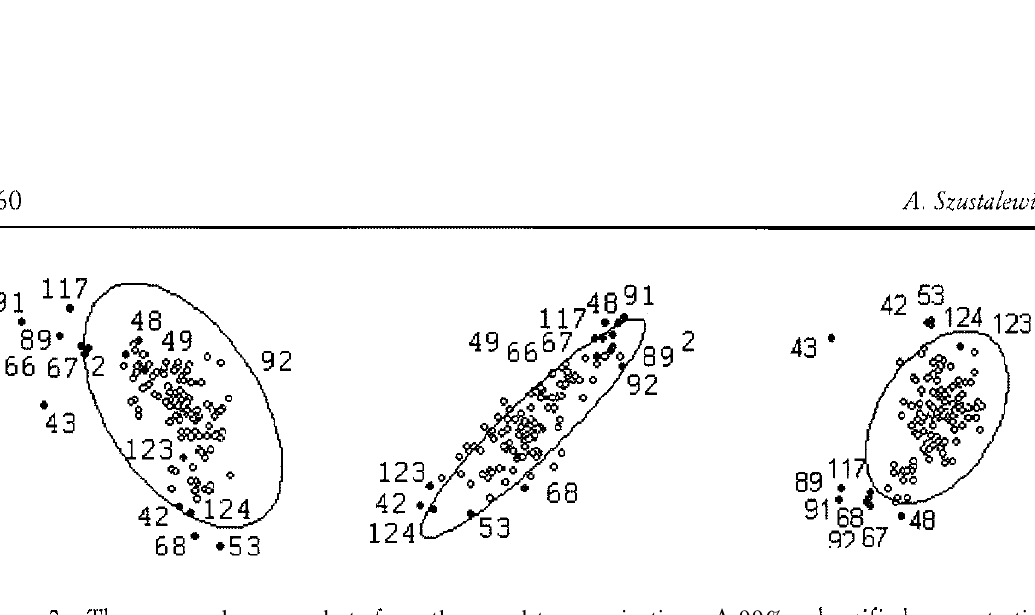
exemplary snapshots the grand tour projections. A 99% concentration ellipse is on of them.